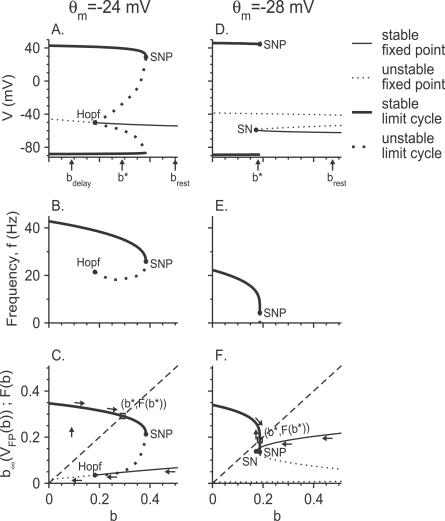
Bifurcation Diagrams and the Fast–Slow Analysis of the Model Neuron(A–C) are for small and (D–F) for large Na+ window currents. Parameters in (A–C) are as in Figure 2C: θ
m = −24 mV, g
d = 0.39 mS/cm2, I
app = 3.35 μA/cm2. Parameters in (D–F) are as in the top panel in Figure 3B: θ
m = −28 mV, g
d = 0.39 mS/cm2, I
app = 1.25 μA/cm2.(A,D) The bifurcation diagram of the fast subsystem in the V-b space.(B,E) The frequency f of the limit cycle of the fast subsystem, plotted as a function of b (f-b curves).(C,F) The functions b
∞(V
FP(b)) and F(b) (Equation 2) plotted as a function of b. Thin solid lines: stable fixed points; thin dotted lines: unstable fixed points; thick solid line: stable limit cycle (periodic state); thick dotted line: unstable limit cycle. Solid circles denote Hopf, saddle-node (SN), and saddle-node of periodics (SNP) bifurcation points. The value of b at rest (I
app = 0) is b
rest, and b* is the value of b at steady state of the neuron. For b
delay, see text. In (C,F), the intersection of the curve b = F(b) with the diagonal dashed line determines the value of b* (open square point). Arrows represent the evolution of the neuron from rest to its steady state following a current step injection of amplitude I
app.